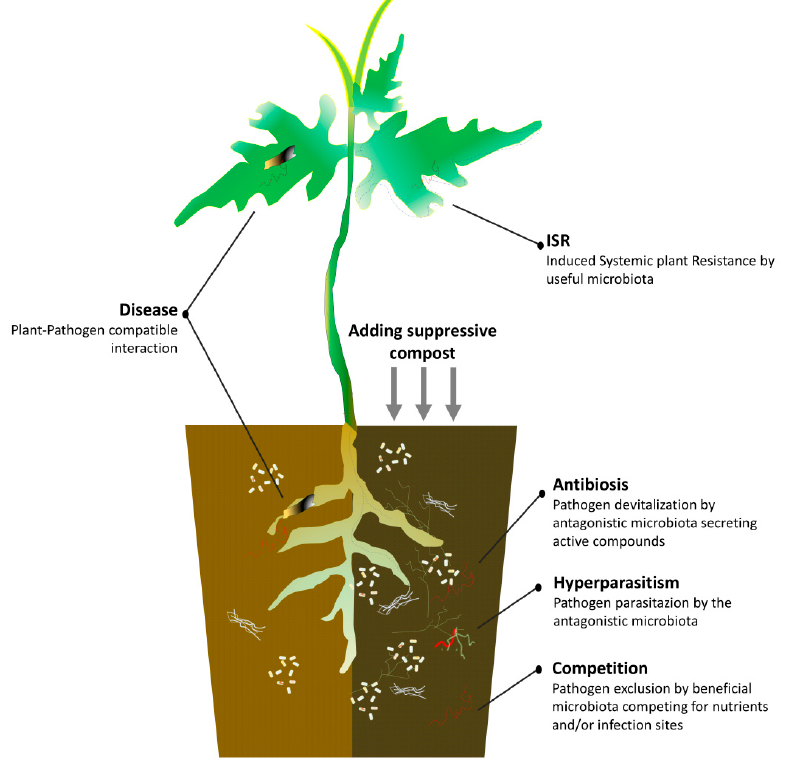
Figure 1. Antagonistic microbial interactions occurring in the rhizosphere on peat-based substrate amended with suppressive compost. amended with suppressive